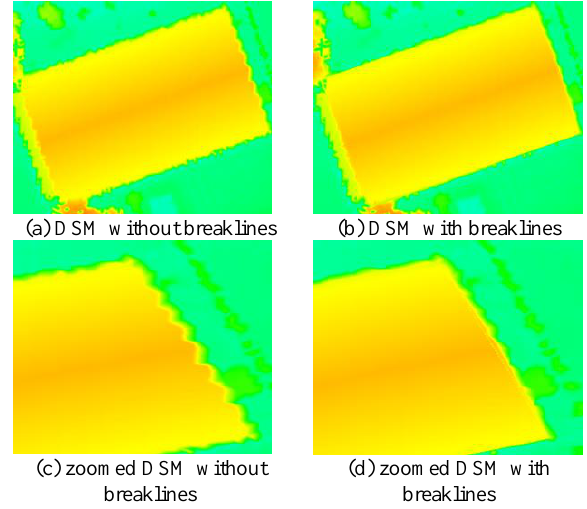
Figure. 7. DSM without breaklines (left) and DSM with breaklines (right) Based on height information, high-rise objects like buildings, trees, or bridges are set back into their true location in the true orthophotos. Therefore, a sharp edge will preserve a correct and straight building representation in true